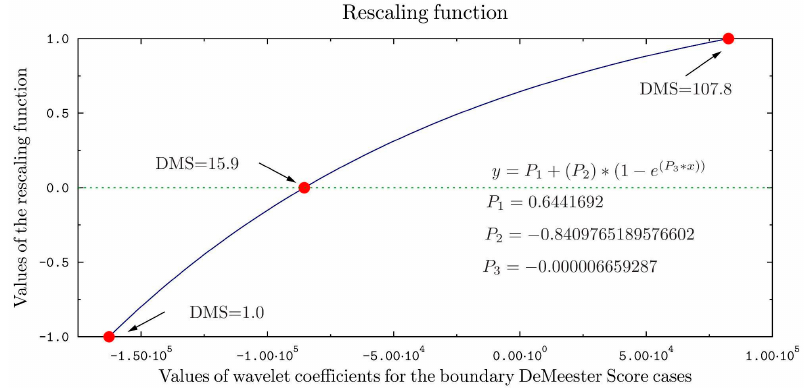
Figure 8. Rescaling function designed based on selected patient cases.